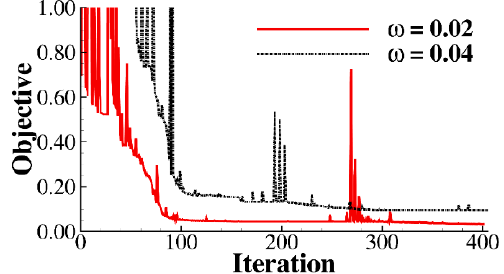
Figure 8. Optimization histories of the supercritical natural laminar flow (NLF) airfoil. Table 3. Aerodynamic performance of the airfoils ( Ma = 0.73, Re = 6.5 × 10 6 ).